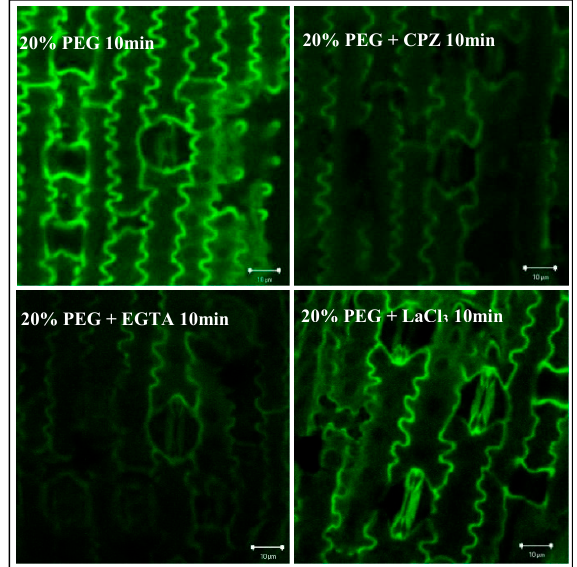
Figure 8. Localization of cellular Ca 2+ dynamics in leaves of P. edulis seedlings treated with different Ca 2+ inhibitors and drought stress. Ca 2+ fluorescence localization in leaves of plants treated with 20% PEG-induced drought stress and 0.1 mmol/L CPZ, 3 mmol/L EGTA, or 0.5 mmol/L LaCl 3 for 10 minutes.